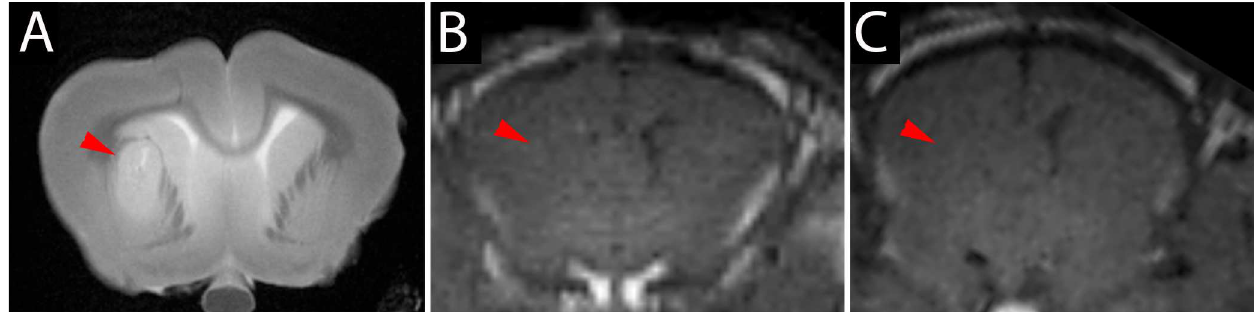
Fig 3. MRI of GBM-1-implanted rabbits. (A) T2-weighted scan showinghyperintense tumor unilaterallynear the thalamus(red arrowhead). T1-weighted scan before (B) and after gadoliniuminjection(C) showinga lack of enhancement within the